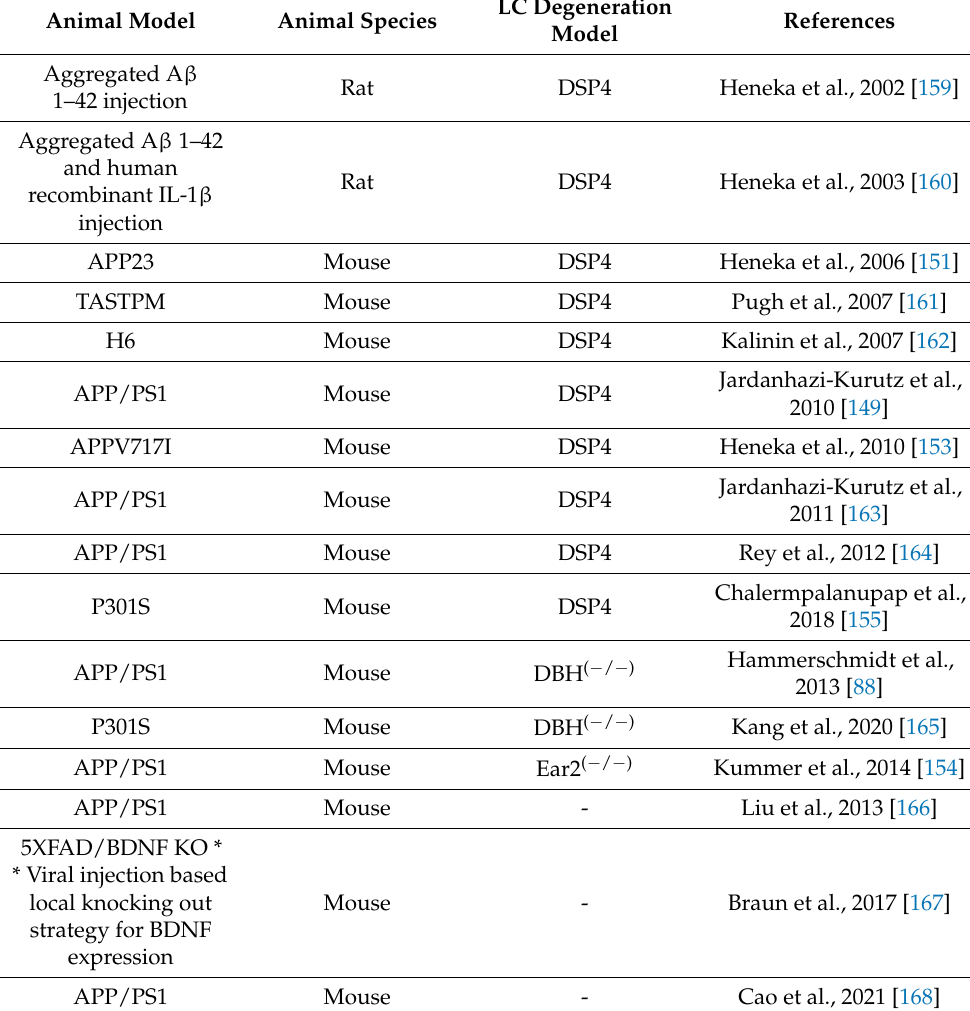
Table 1. In vivo models used to investigate the role of LC degeneration in AD progression. In order to examine the consequences of the LC degeneration in AD in general, either knockout mouse models, such as DBH ( − / − ) , Ear2 ( − / − ) , or selective neurotoxins, such as DSP4, have been used in combination with amyloid or tau transgenic mice. DSP4 is a selective neurotoxins and it destroys the NA terminals originating from the LC [156]. DBH ( − / − ) animals are lacking NA since birth [157]. Ear2 ( − / − ) mice lack ∼ 70% of the LC neurons projecting to the hippocampus and neocortex [158] from